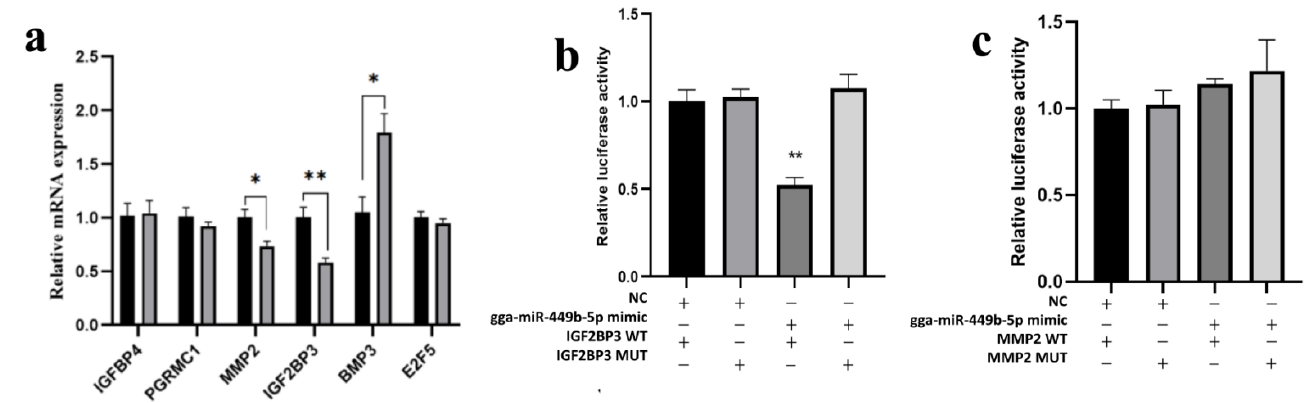
Figure 4. IGF2BP3 is directly targeted by gga-miR-449b-5p. ( a ) The mRNA expression of potential target genes following transfection with gga-miR-449b-5p mimics; ( b ) Dual-luciferase reporter assay of the DF-1 cell line cotransfected with gga-miR-449b-5p mimics and IGF2BP3 3 ′ UTR -WT or IGF2BP3 3′ UTR -MUT; ( c ) Dual-luciferase reporter assay of the DF-1 cell line cotransfected with gga-miR-449b-5p mimics and MMP2 3 ′ UTR -WT or MMP2 3′ UTR -MUT. ** and * indicated that there were significant differences ( p < 0.01) and significant differences ( p < 0.05), respectively.